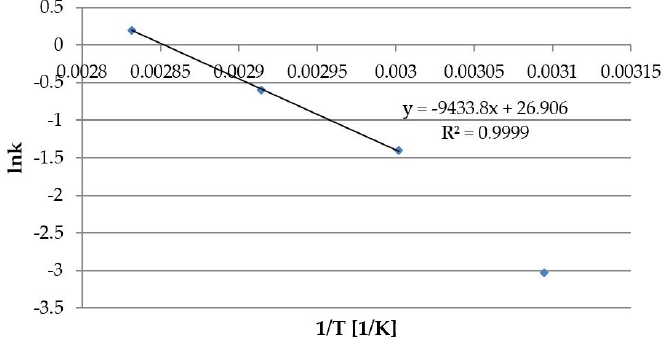
Figure 4. Arrhenius plot for solid Lf isolate sample 1 (c 0 = 1.0 mg/mL) based on zero-order rate constants for the degradation of Lf at 50 − 80 °C.